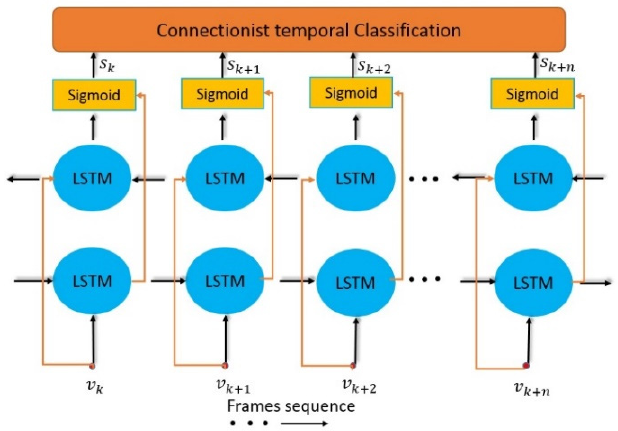
Figure 2. Gesture segmentation with Bi_LSTM and CTC loss.